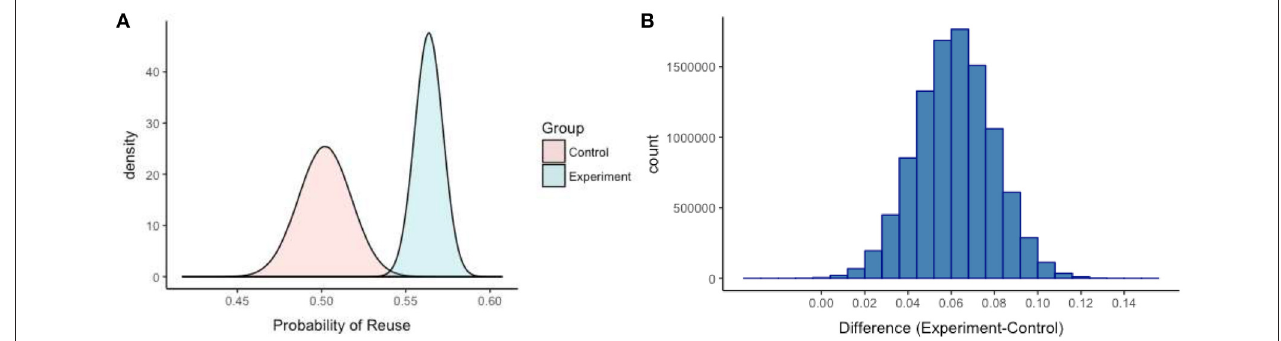
FIGURE 1 | The posterior probability distributions of the combined control and experiment groups are displayed in (A) based on 10 million samples (hotel towel reuse in proportions). (B) Visualizes the posterior distribution of the difference between the control and experiment proportions.